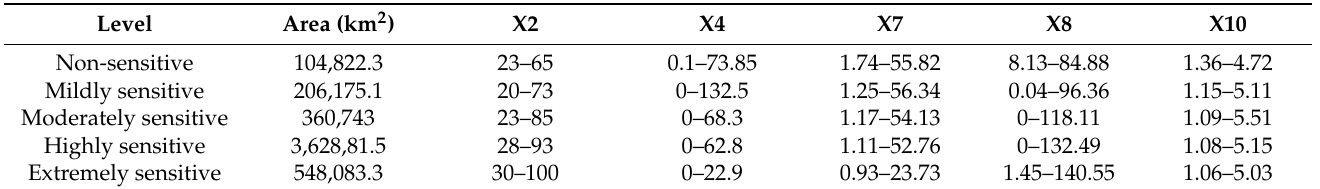
Table 2. Statistics of evaluation indexes corresponding to each level of desertification